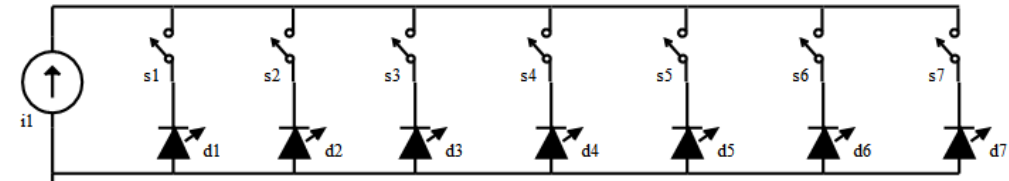
Figure 1. A schematic diagram of the multispectral light source showing the connection layout of the LEDs (d1–d7) and the constant current source (i1) via switches (s1–s7).